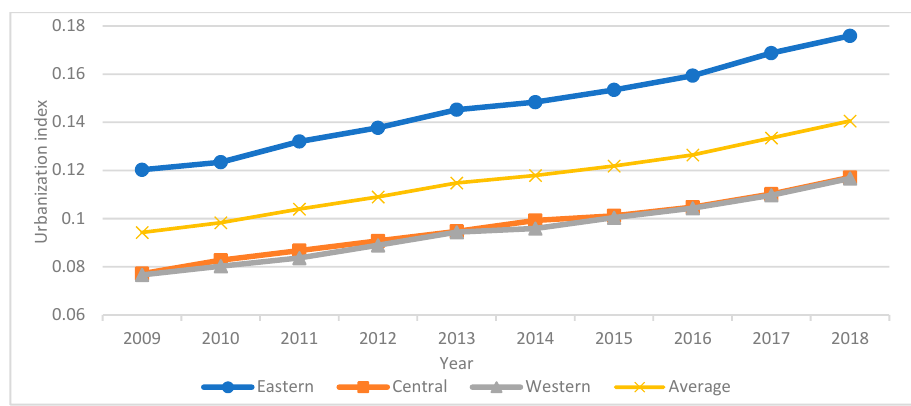
Figure 3. Changes in the urbanization index in the eastern, central and western regions over time.